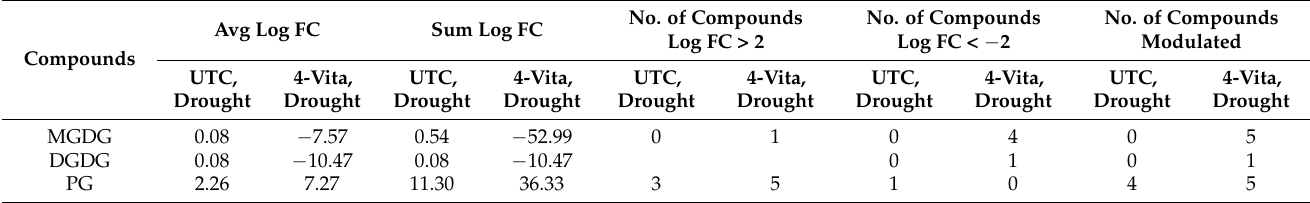
Table 7. Fatty acid and lipid biosynthesis processes modulated by 4-Vita in tomato plants under drought stress conditions, compared to untreated control (UTC, well-watered).